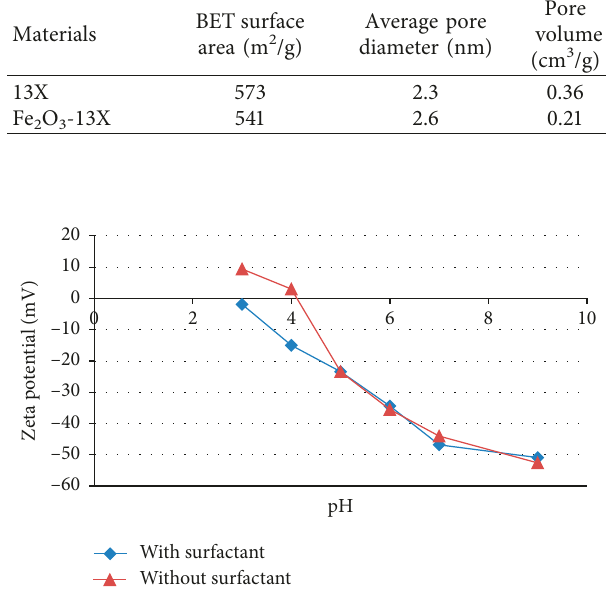
Figure 4: Zeta potential of Fe 2 O 3 -13X-Ms versus the solution pH.